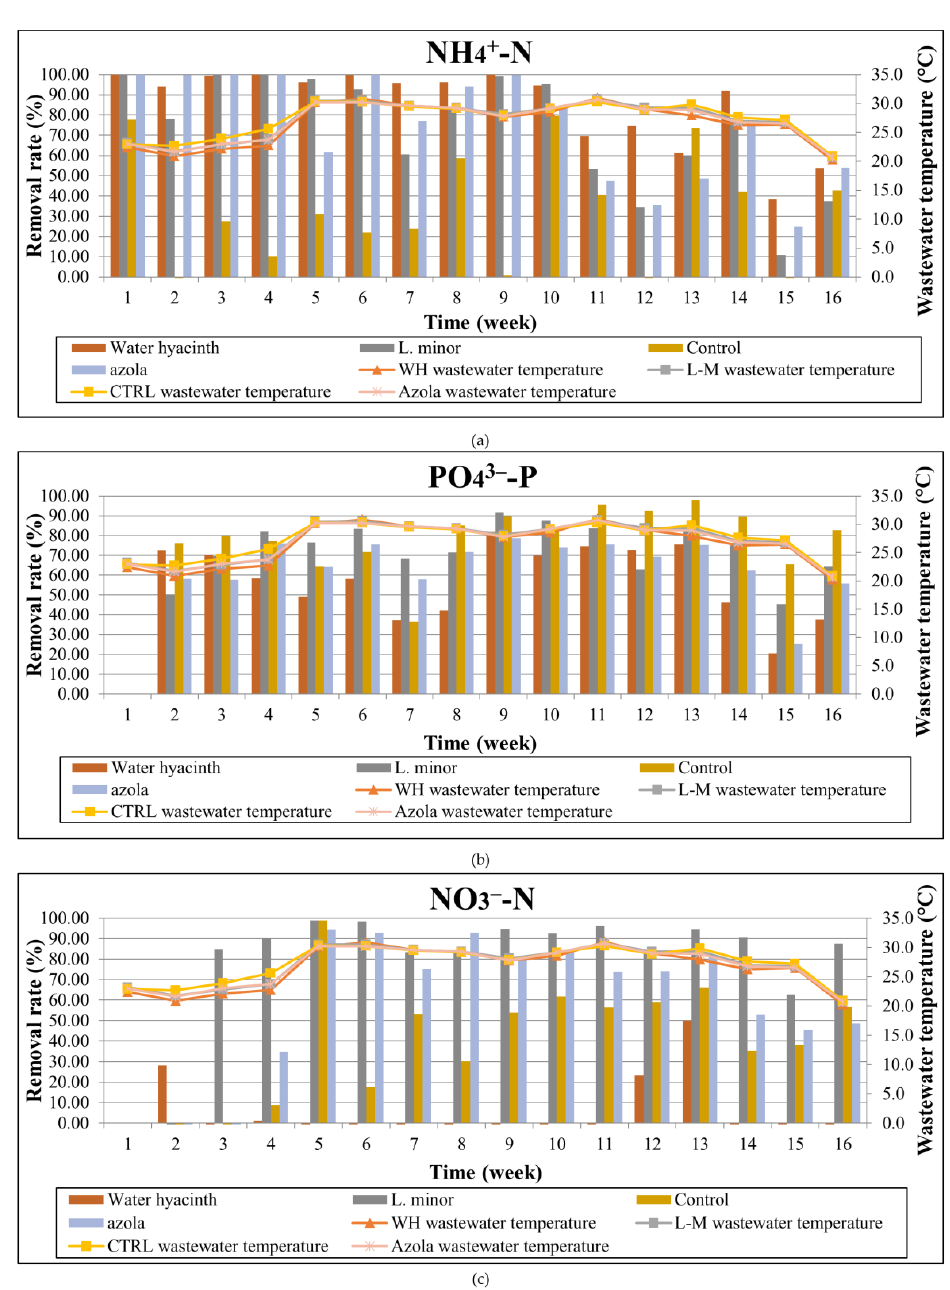
Figure 6. Temporal evolution of removal rate per examined tank and wastewater temperature for: ( a ) NH 4+ -N, ( b ) PO 43 − -P, and ( c ) NO 3 − -N. As can be seen from the graphs, ammonium ions exhibited reduction percentages ranging from 38.3% to 100% for water hyacinth, 11% to 100% for L. minor , 24.8% to 100% for A. pinnata , and up to 79% for the control tank. It is, therefore, noticed that the water hyacinth presented the highest reduction between the three aquatic macrophytes. The mean removal rates for the whole experiment period were thus 91.9% for water hyacinth, 84.3% for azola, 84.7% for lemna and 41.8% for the control tank. Phosphate ions also presented significant reductions that ranged from 20.6% to 81.9% for water hyacinth, 45.5% to 91.6% for lemna, 25.3% to 78.8% for azola and between 36.6% to 98% for the algae control system, values demonstrating that the presence of